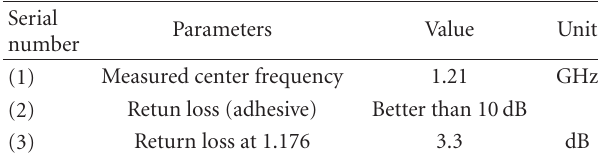
Table 2: Measurement of 1.176 GHz antenna.